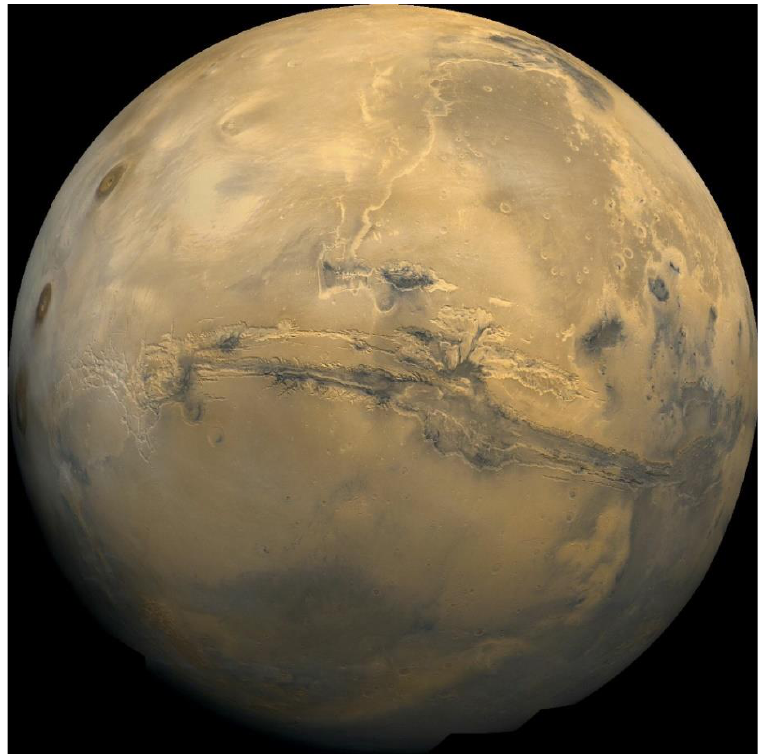
Figure 15. The Valles Marineris canyon system.